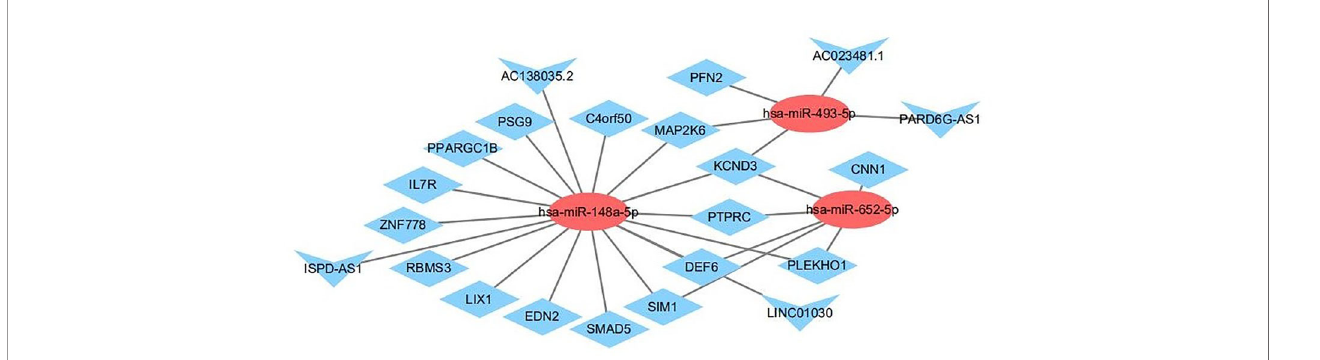
FIGURE 11 | The interaction network of lncRNA – miRNA – mRNA. Red and blue represent up- and down-regulation, respectively. Triangles represent DE-lncRNAs, circles represent DE-miRNAs, and diamonds